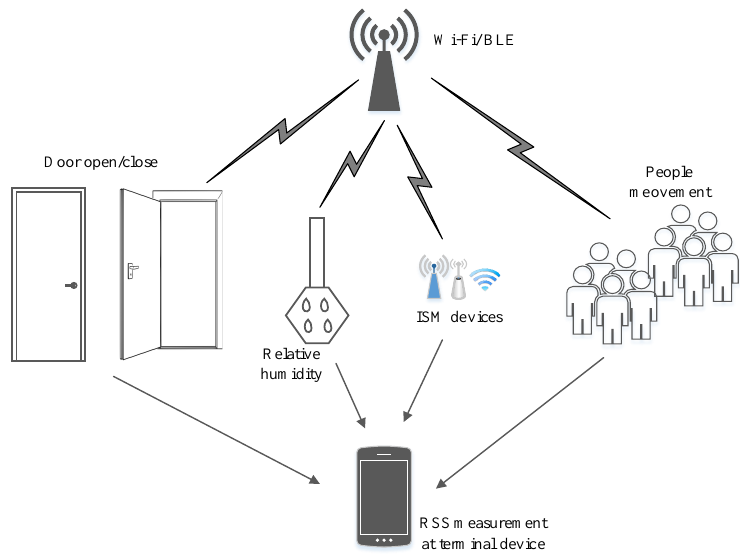
Figure 6. Graphical representation of interference at indoor